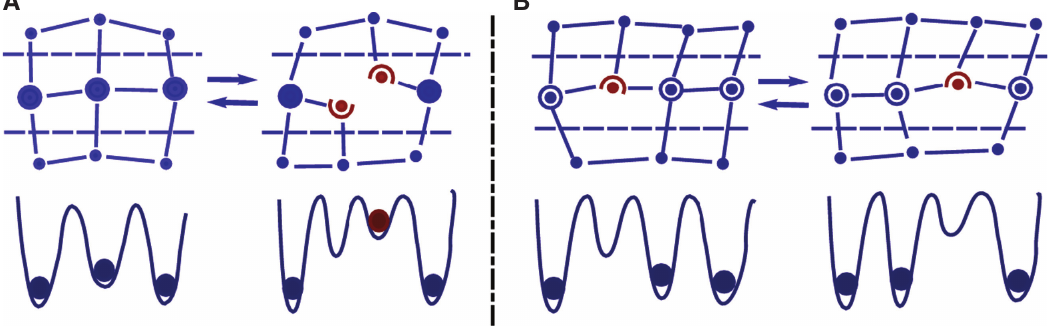
Figure 1 Elementary rearrangements under shear